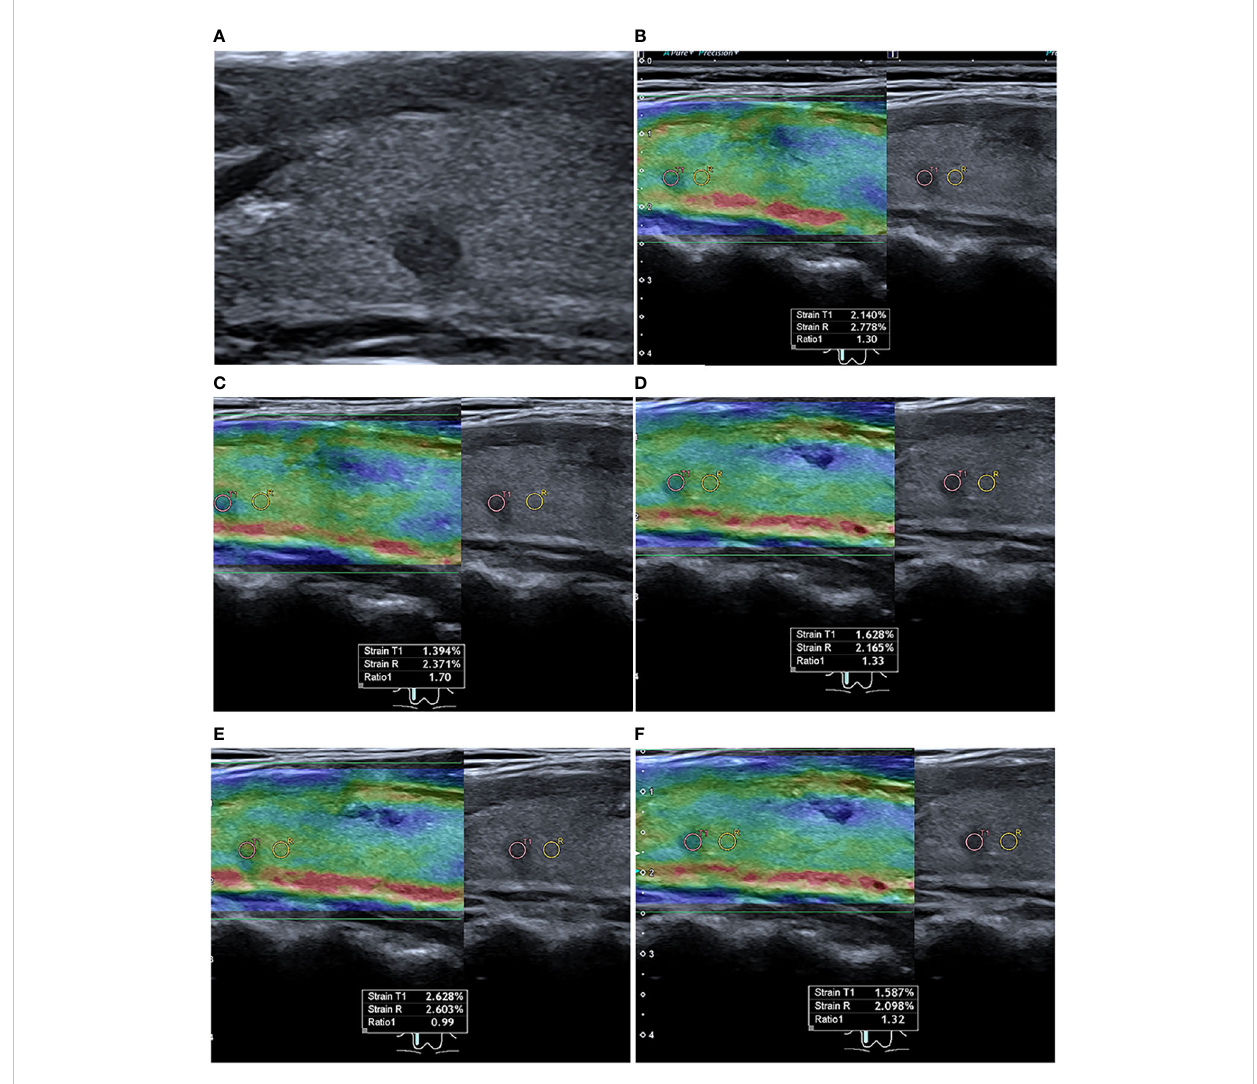
FIGURE 5 Conventional and strain ultrasound elastography of a 45-year-old female PTC patient without occult central lymph node metastasis. (A) Conventional ultrasound shows a hypoechoic nodule in the upper right lobe of the thyroid gland with a maximum diameter of 4.70 mm. (B – F) Five strain ultrasound elastography images were obtained, with strain ratios of 1.30, 1.70, 1.33, 0.99, and 1.32,